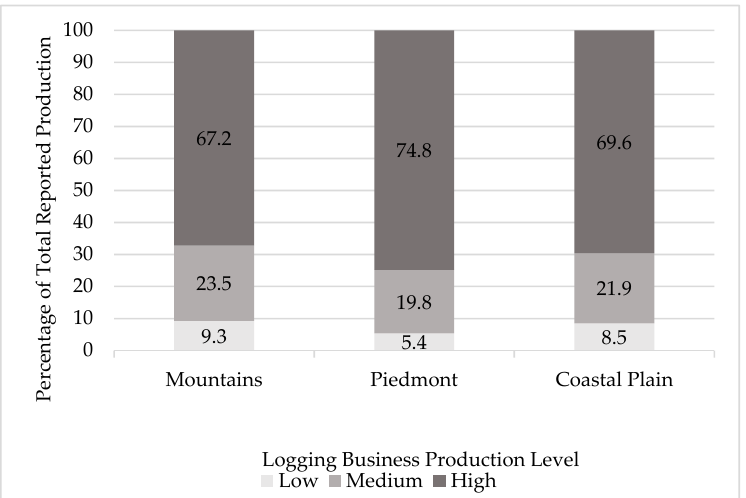
Figure 6. Percentage of total reported production by region associated with low, medium, and high production logging businesses when categorized based on the upper, middle, and lower thirds of logging business production levels.